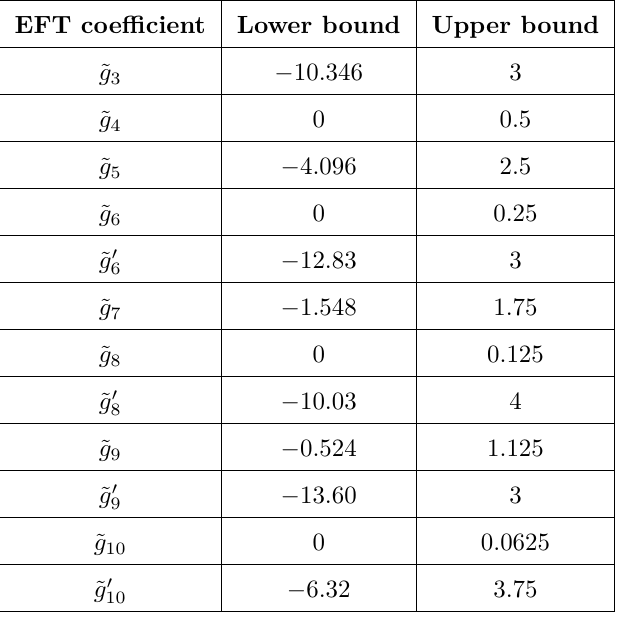
Table 3. Bounds on coefficients ˜ g ( p )